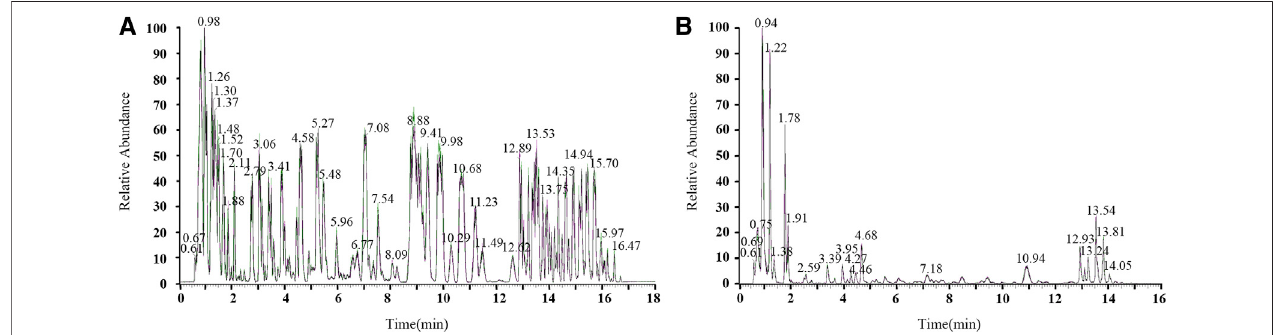
FIGURE 2 | Chromatogram of the quality control sample in ESI-positive (A) and ESI-negative (B) ion modes.